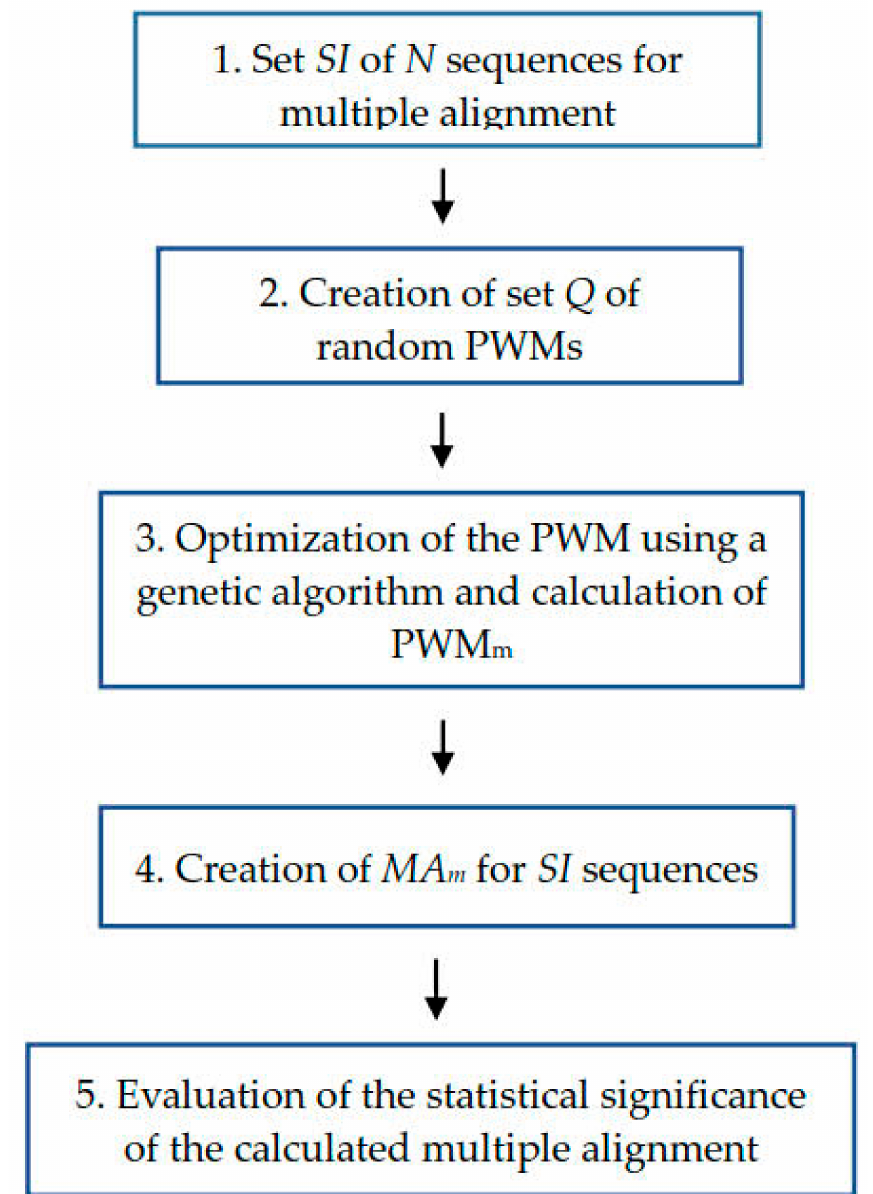
Figure 1. Diagram of the algorithm for multiple alignment of amino acid sequences shown in Section 4.1. Set of N sequences for multiple alignment is denoted as SI . Q is set of random PWMs (see Section 4.2). PWM m is matrix that has the maximum value of the similarity function when aligning sequences from the set SI (see Section 4.3 and Formula (4)). MA m is a multiple alignment built for sequences from SI set using PWM m (see Section 4.5 and Formula